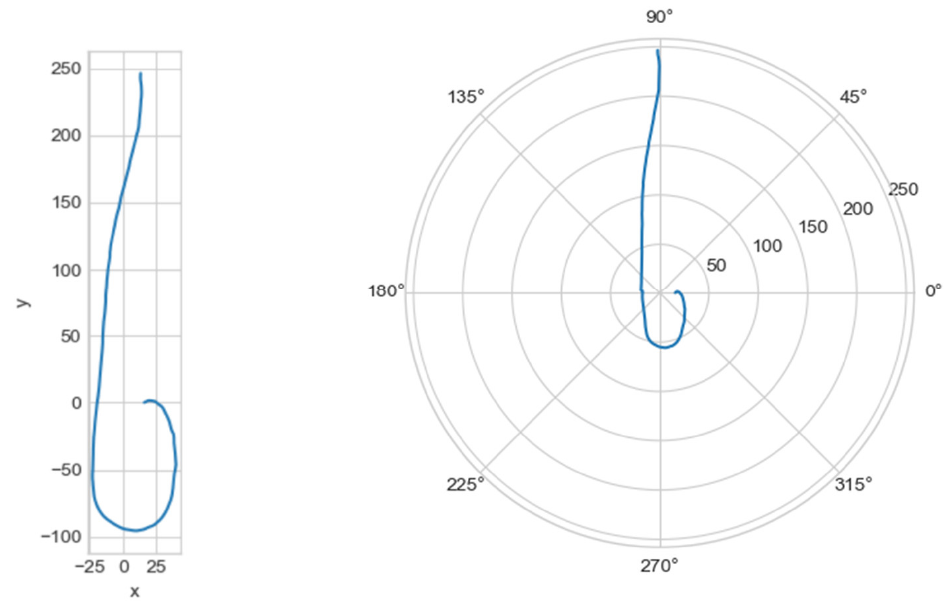
Figure 5. On the left—the projection of the central line in the Cartesian coordinate system, on the right—in the polar coordinate system.